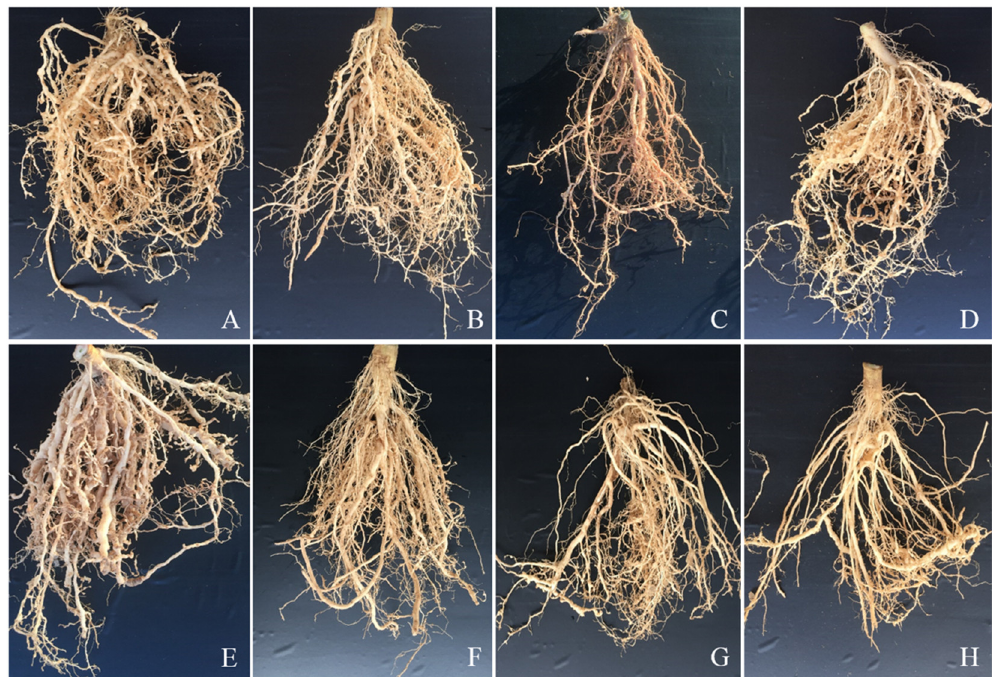
Figure 4. Root of tomato plants after treatment with ( A , E ) water (control), ( B ) 10 mg / plant FAc, ( C ) 50 mg / plant FAc, ( D ) 10 mg / plant avermectin, ( F ) 375 mg / m 2 FAc, ( G ) 750 mg / m 2 FAc, and ( H ) 750 mg / m 2 metam sodium for 60 days in the field. ( A – D ): Chemicals were irrigated into the